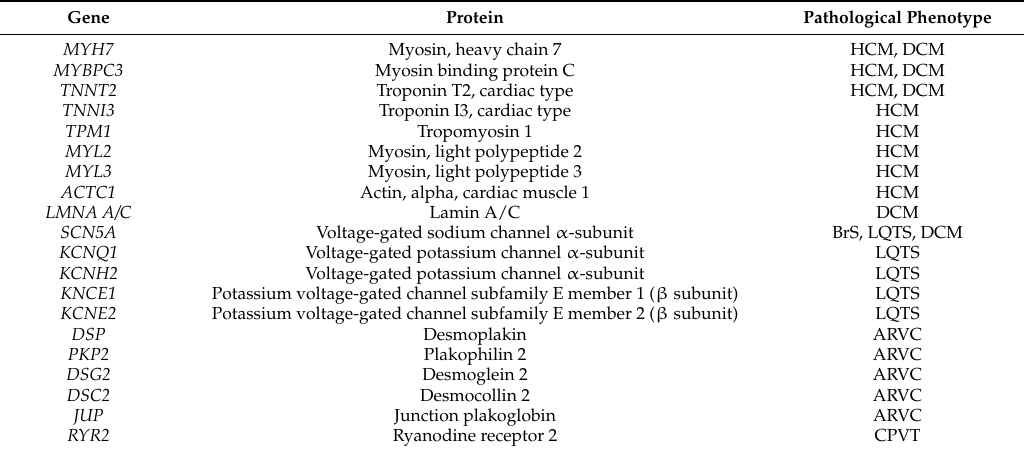
Table 1. Panel of genes screened according to diagnostic